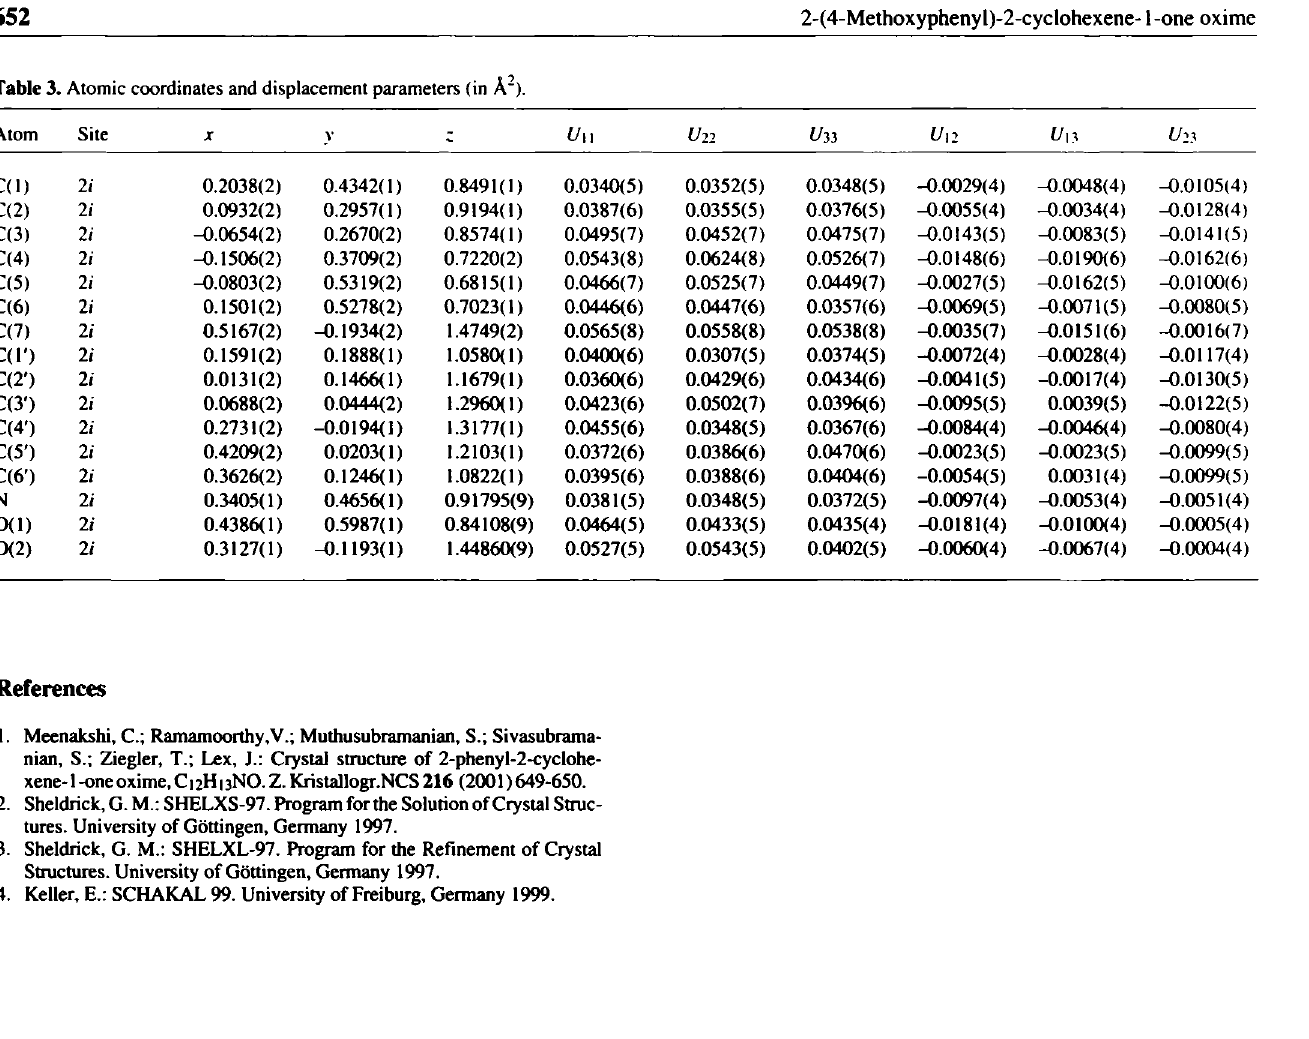
Table 3. Atomic coordinates and displacement parameters (in A 2